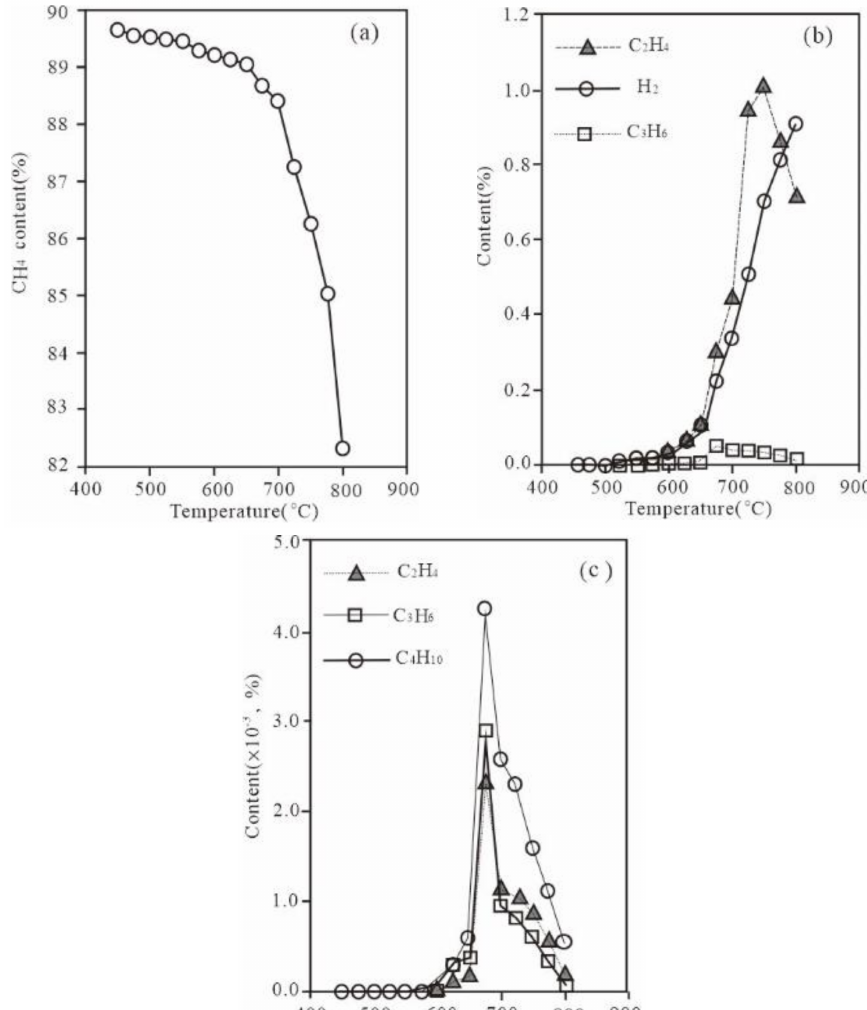
Figure 2. Concentration variation of gaseous components with increasing temperature. ( a ) Variation of CH 4 content with increasing experimental temperature. ( b ) Content variation of C 2 H 6, C 2 H 8 and H 2 with increasing experimental temperature. ( c ) Content variation of C 2 H 4, C 2 H 6 and C 4 H 10 with increasing experimental